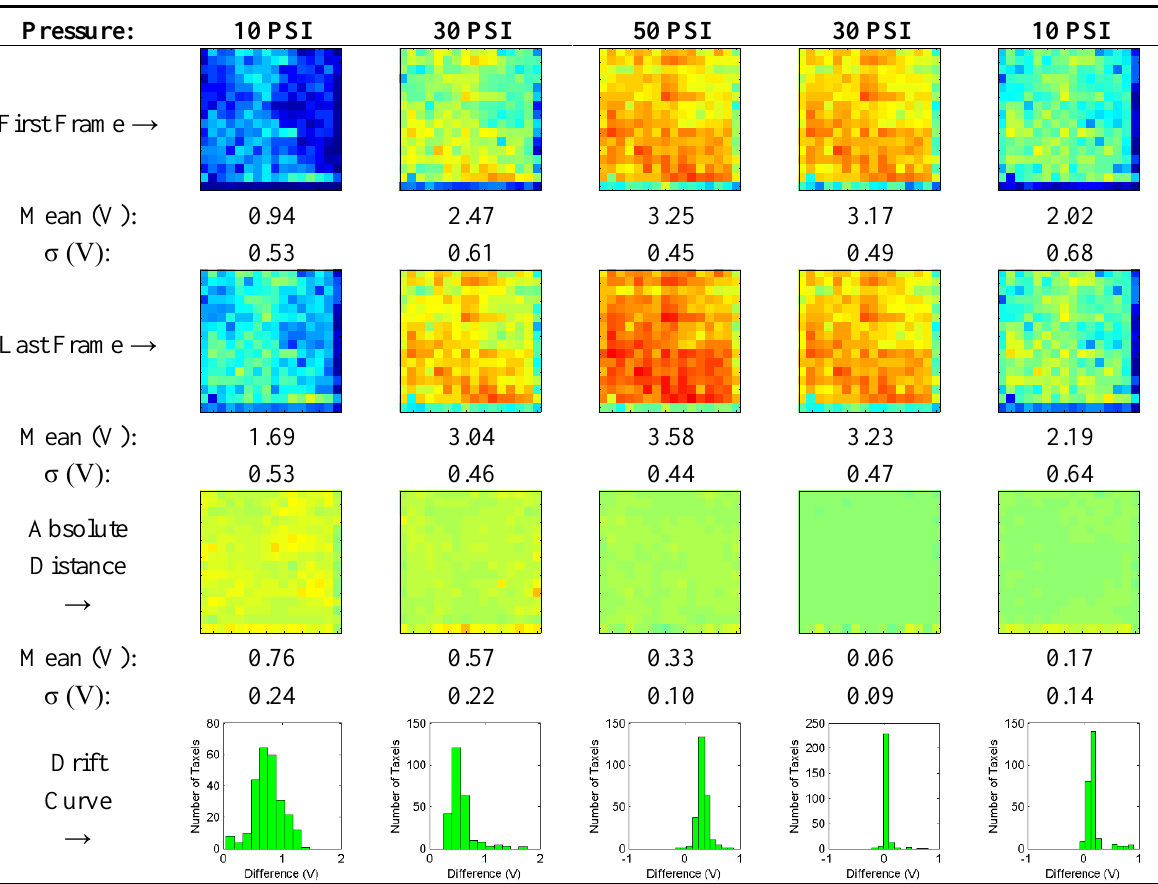
Table 2. Tactile images from the PCB based sensor obtained for different increments and decrements of the uniform force on its